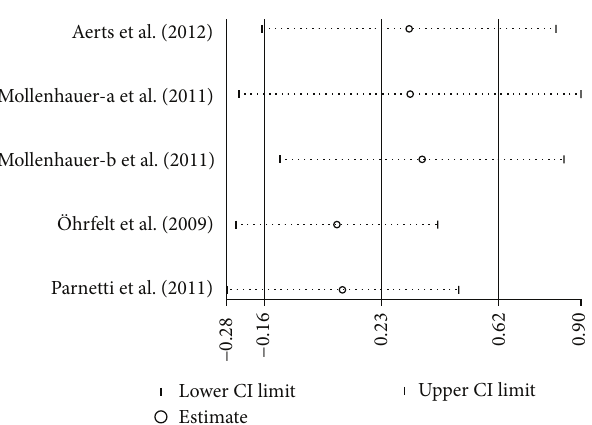
Figure 10: Sensitivity analysis of CSF 𝛼 -syn levels in PD compared to DLB.